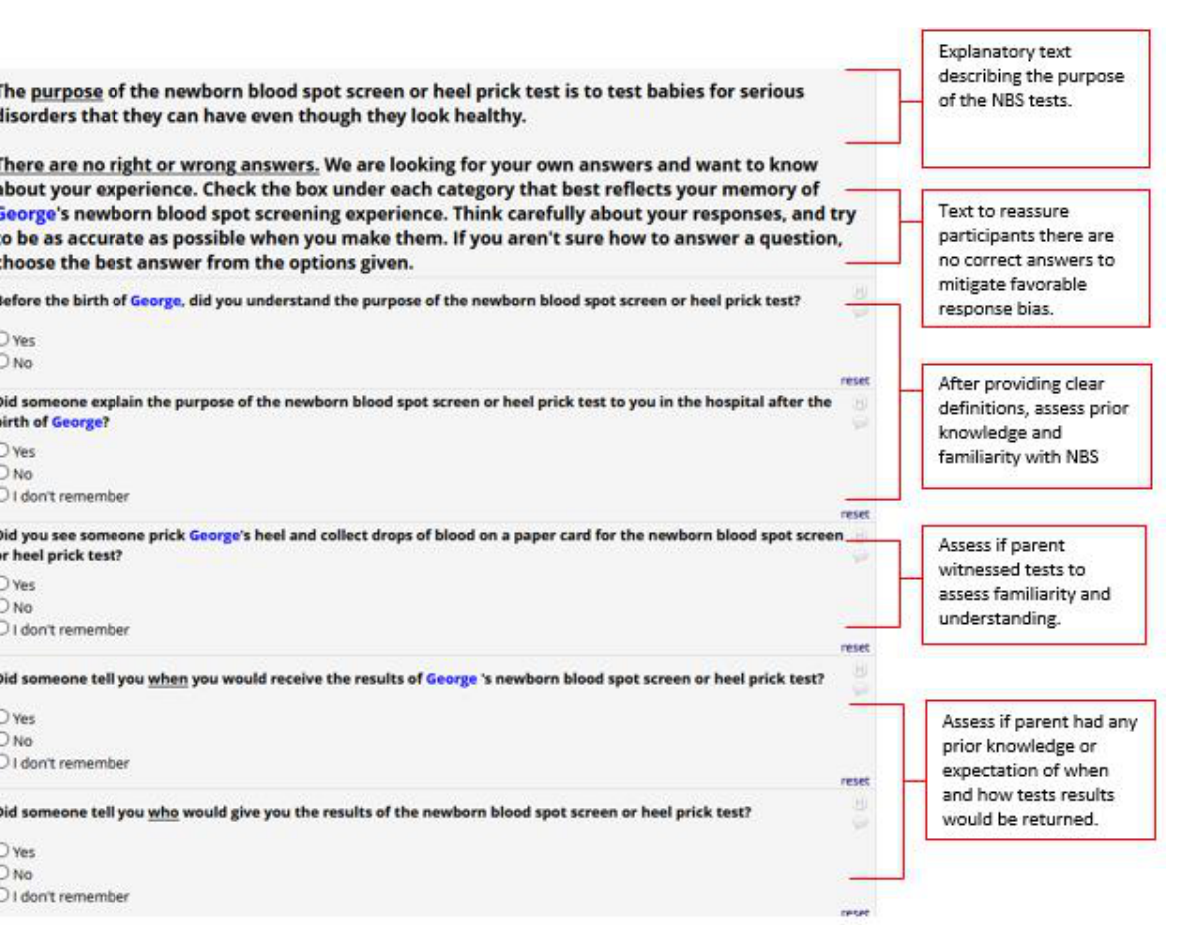
Figure 2. Newborn Screening Test Example Questions after Revision